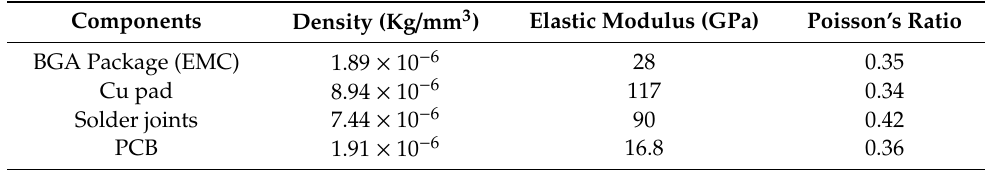
Figure 10. 3D finite element analysis (FEA) model. Table 4. Mechanical properties of the components.